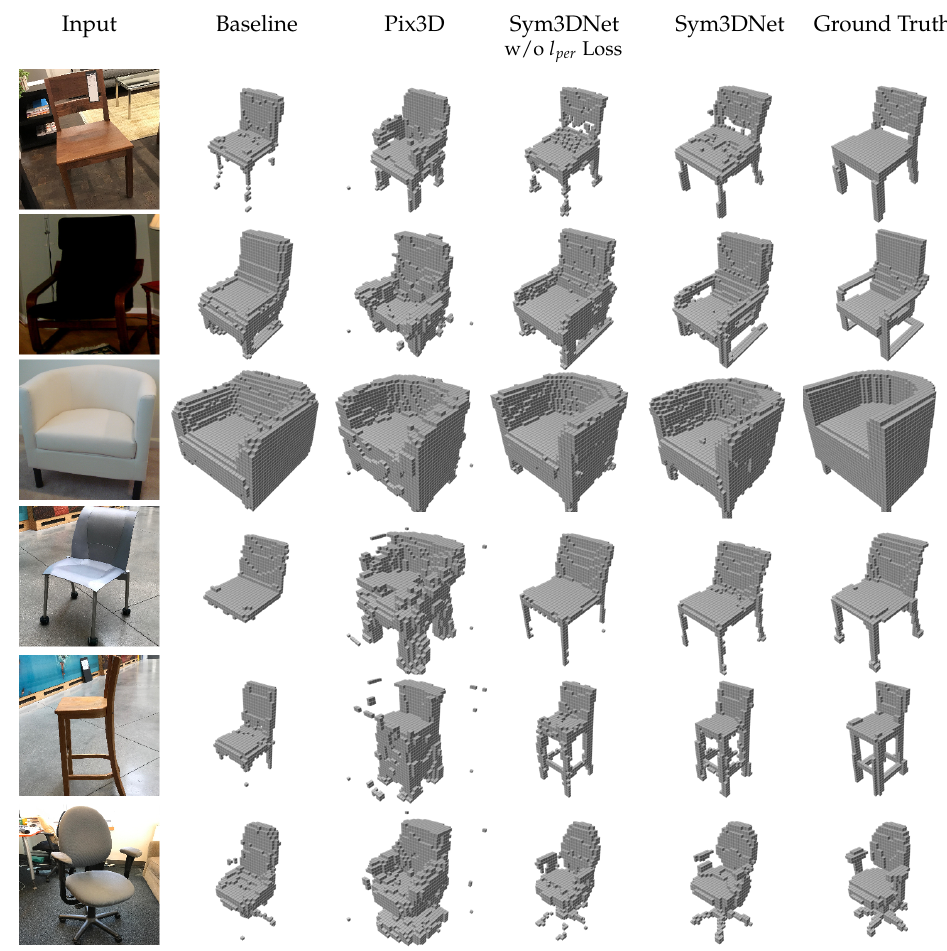
Figure 7. Three dimensional reconstruction from single view on the Pix3D testing set of chair category.